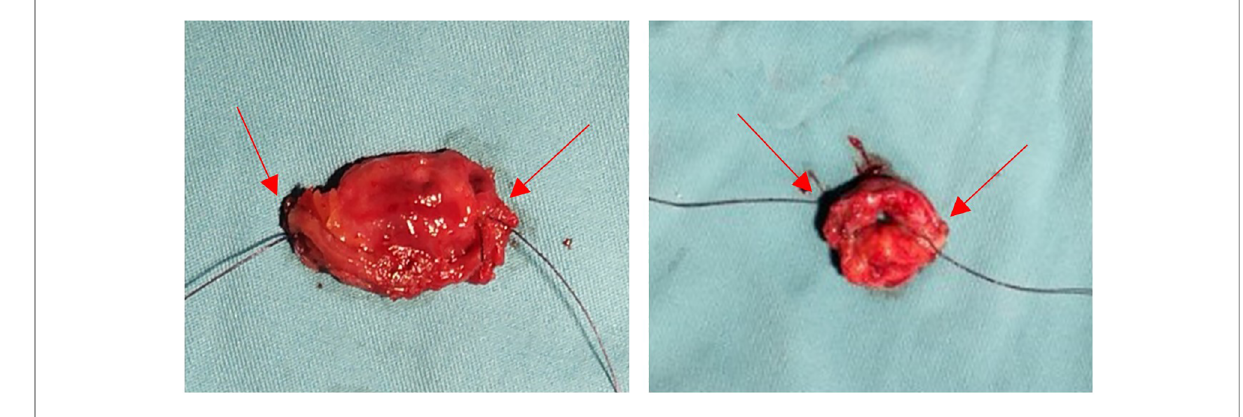
FIGURE 2 All of the dog-ears were cut down with a circular stapler (the red arrow marks the